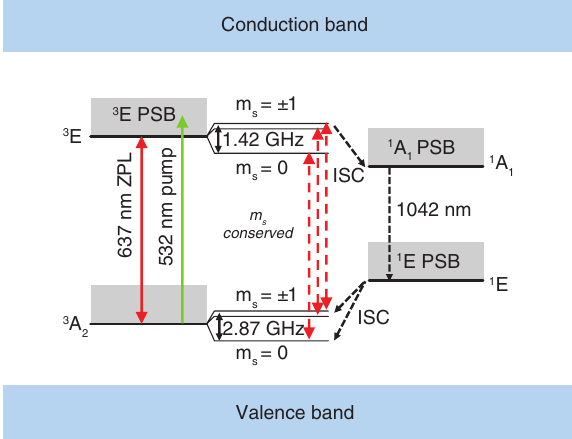
Figure 3: NV radiative and nonradiative state transitions. Radiative 3 E ↔ 3 A transition with optical 637-nm zero-phonon line 2 (ZPL), and 1 E ↔ 1 A transition with non-optical 1042-nm ZPL. Phonon 1 sidebands (PSBs) can shift the transition frequencies. Nonradiative intersystem crossing (ISC)-mediated transitions exist between 3 E and 1 A and between 1 E and 3 A 1 2